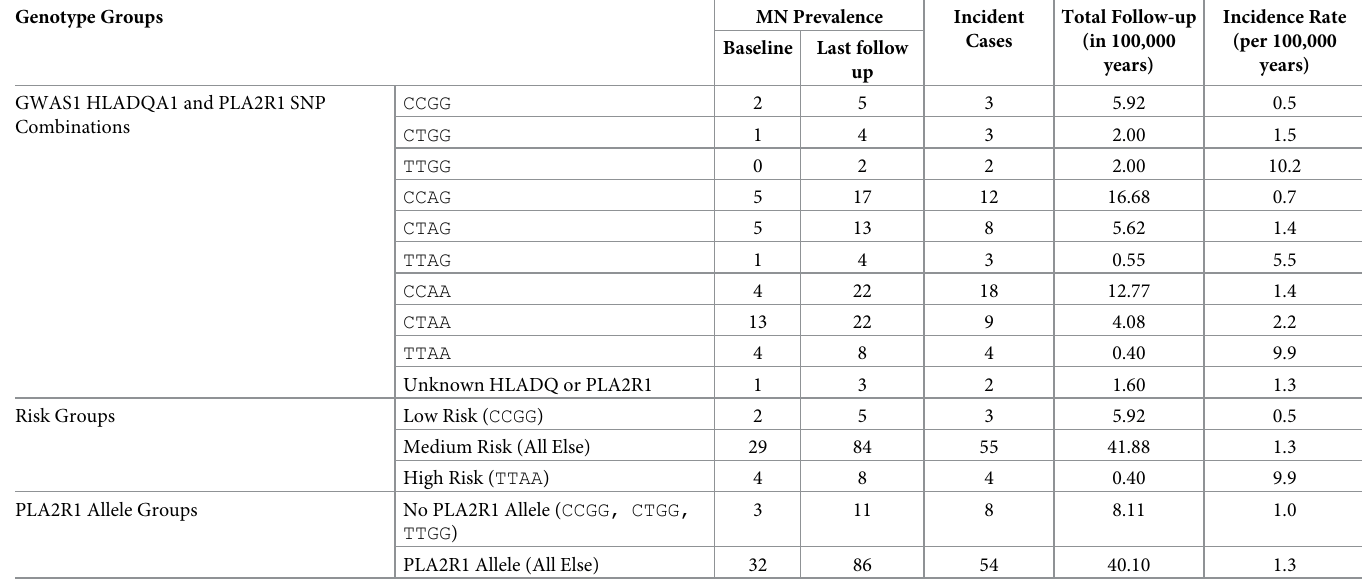
Table 5. Prevalence and incidence measures for: Those in high-risk and low-risk groups; those with a PLA2R1 allele and without a PLA2R1 allele. Genotype Groups